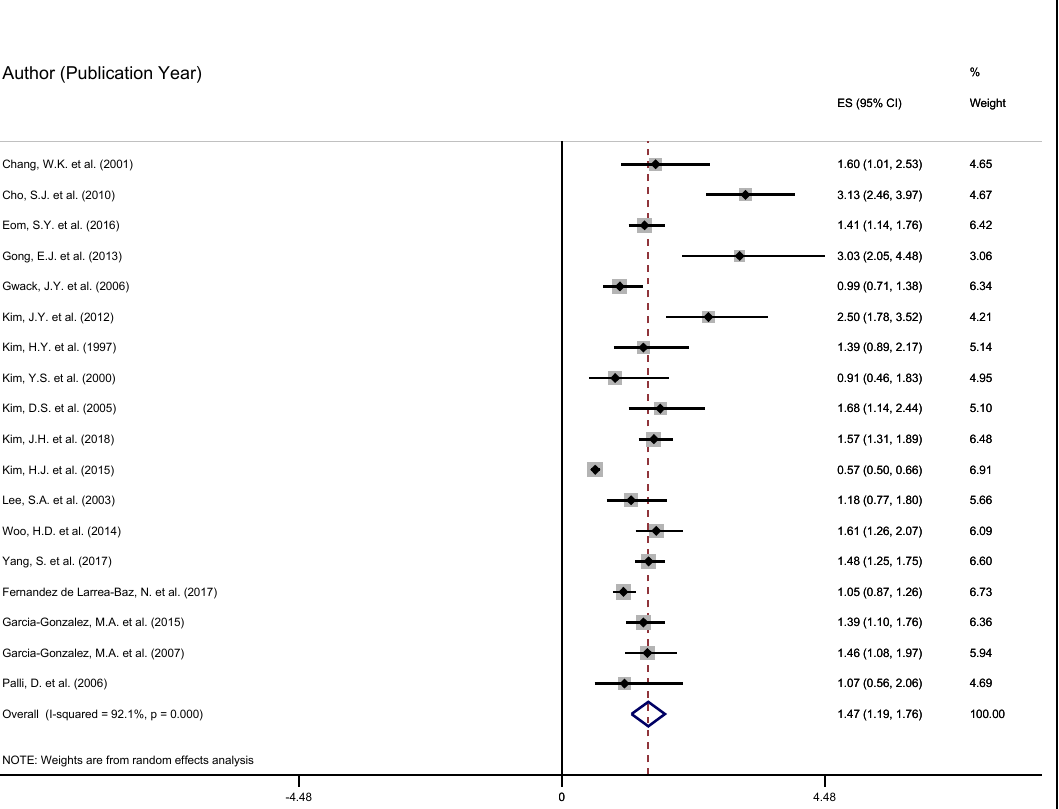
Figure 2. Forest plot of the correlation between H. pylori and gastric carcinoma. The diamond illustrates the common effect size (CES), while the error bars between the dots and the individual effect sizes represent the 95% lower and upper confidence intervals, respectively.